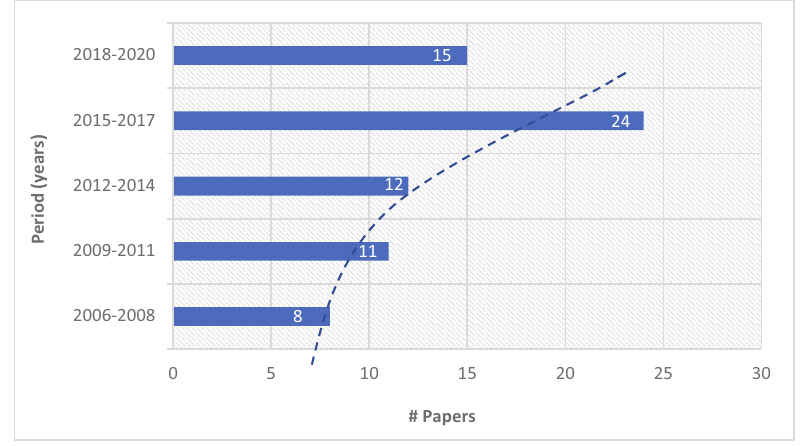
Figure 2. Publications, each three years of the surveyed papers.